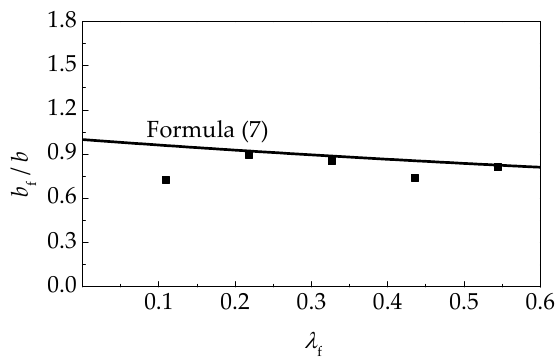
Figure 15. Relationship between λ f and α cf / α c.